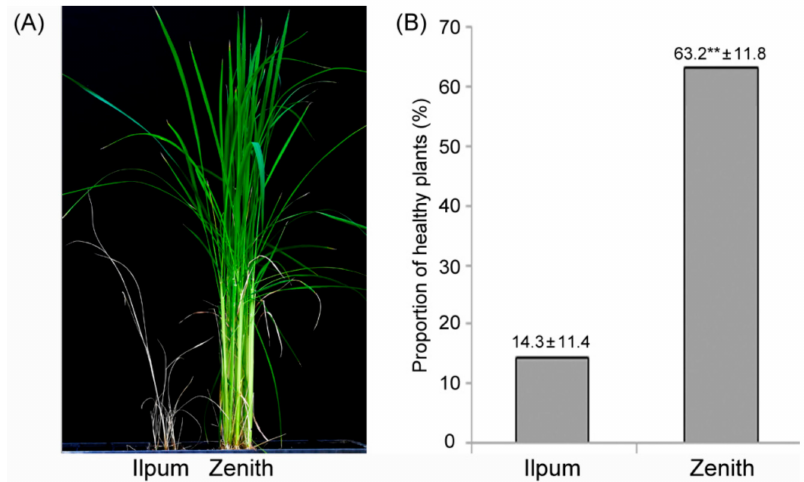
Figure 1. Phenotype ( A ) and proportion of healthy plants ( B ) in Ilpum and Zenith infected with the Fusarium fujikuroi isolate CF283. ** Significant at the 1 % level.